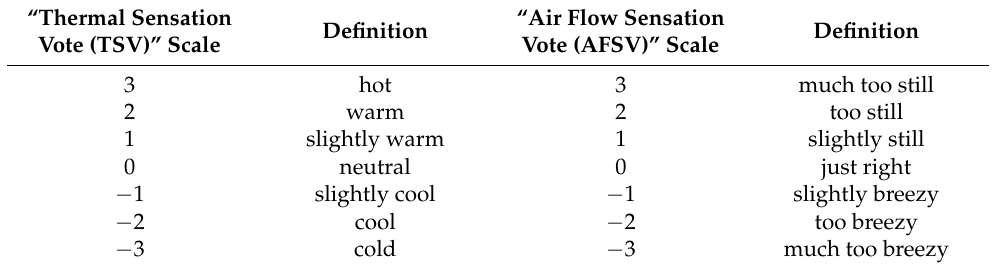
Table 6. Questionnaire scales and definitions.